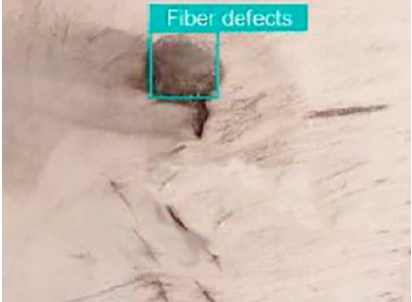
Figure 4. Photo of the blade fiber defects [33].